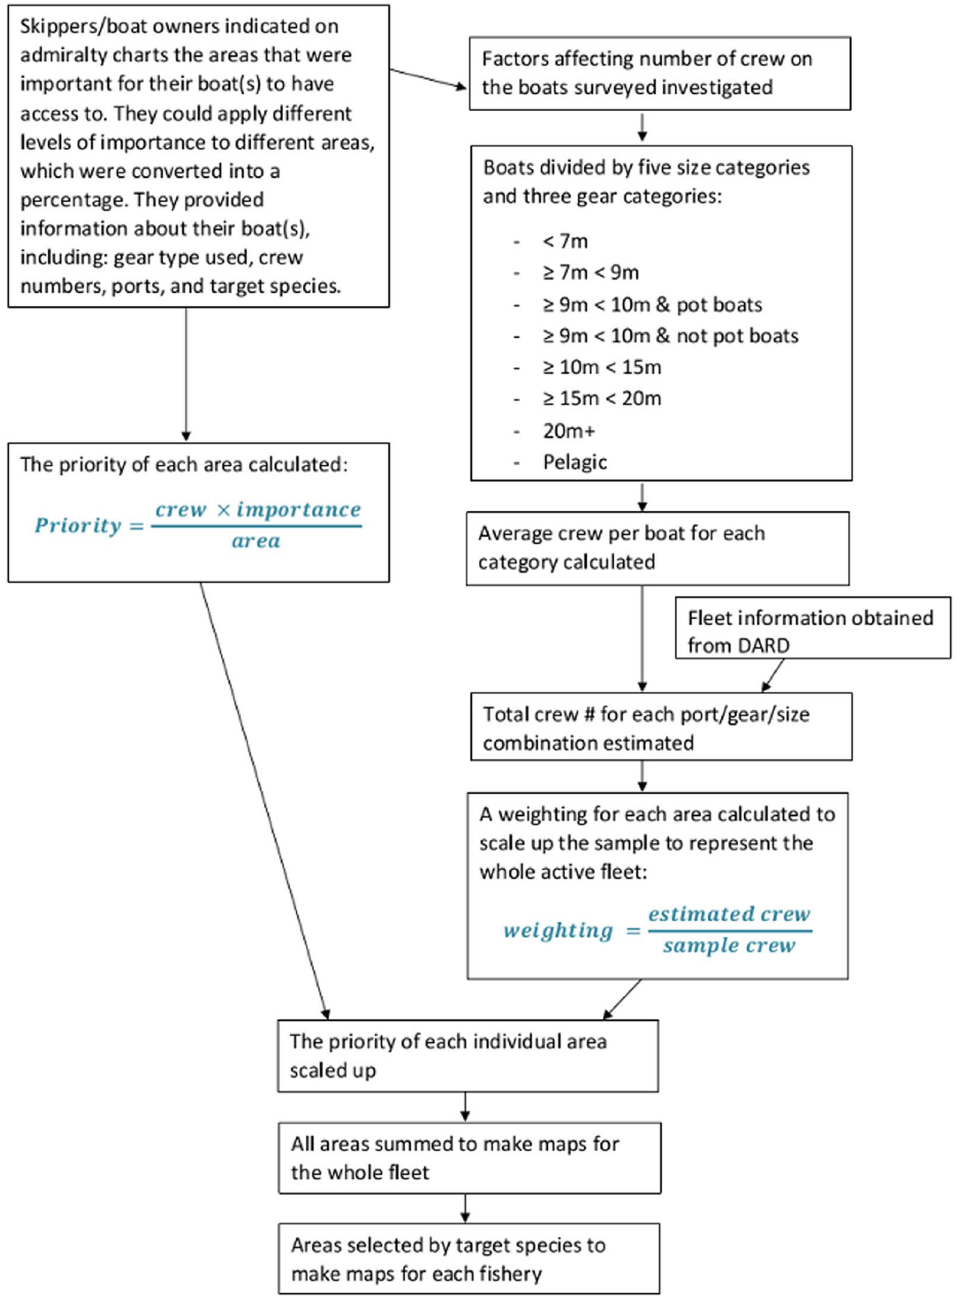
Figure 5. Flow diagram of the Spatial Access Priority Mapping Method. Flow diagram of the Spatial Access Priority Mapping Method use to map the access priorities of the Northern Ireland fleet in 2012. DARD stands for the Department of Agriculture and Rural Development, Northern Ireland.